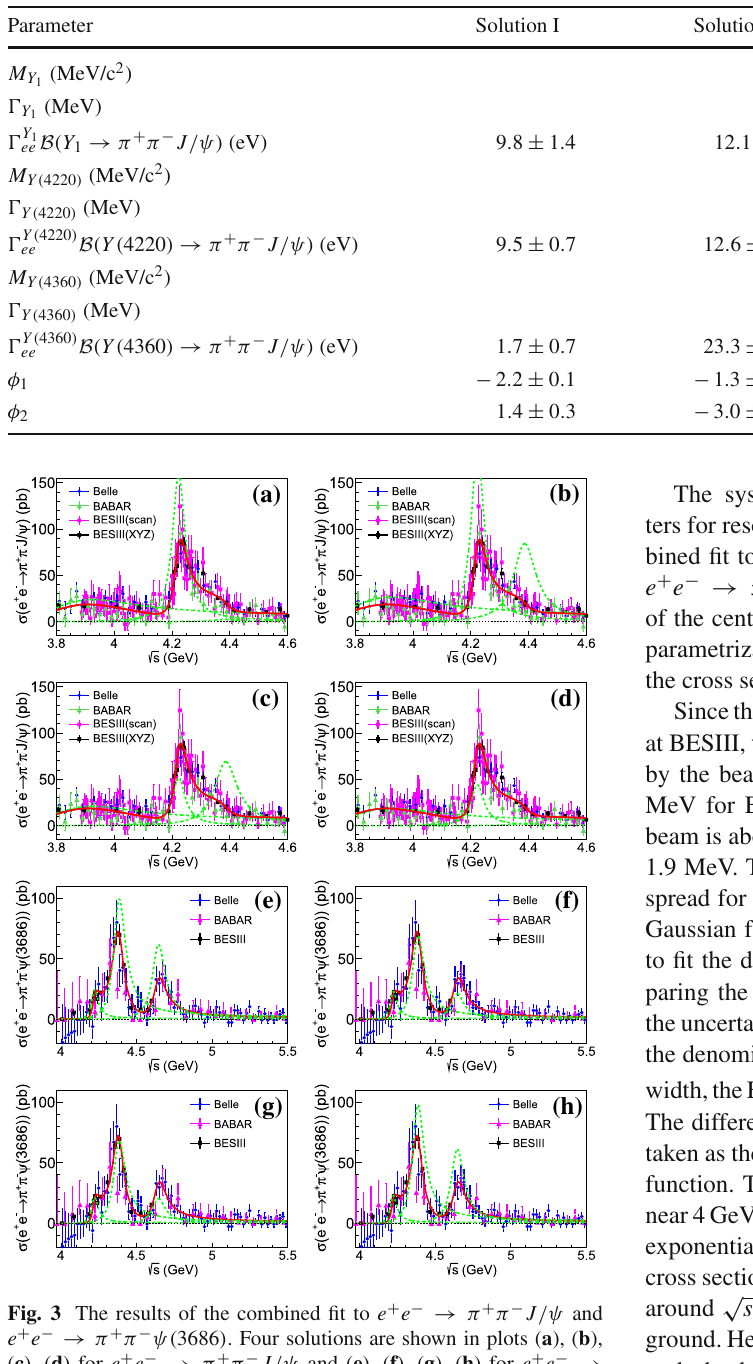
and the goodness of the fit is χ 2 / nd f = 284 . 1 / 305, corre- sponding to a confidence level of 80%. The obtained param- eters of the cross sections of e + e − → π + π − J /ψ and e + e − → π + π − ψ( 3686 ) are listed in Table